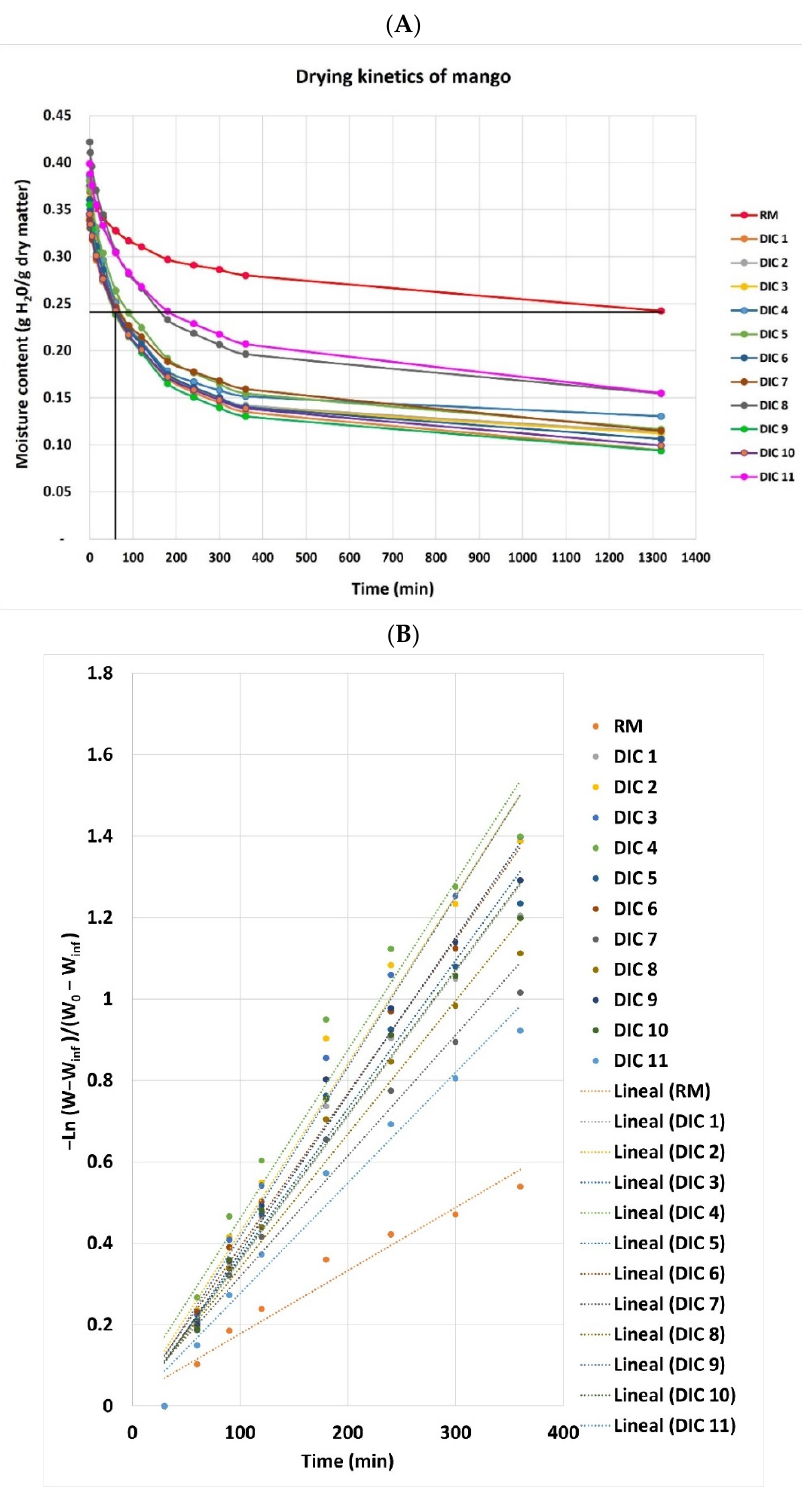
Figure 6. ( A ) Drying curves of raw material (RM) and swell-dried mangoes (DIC) and ( B )–ln(Y) vs. time (min) plot.